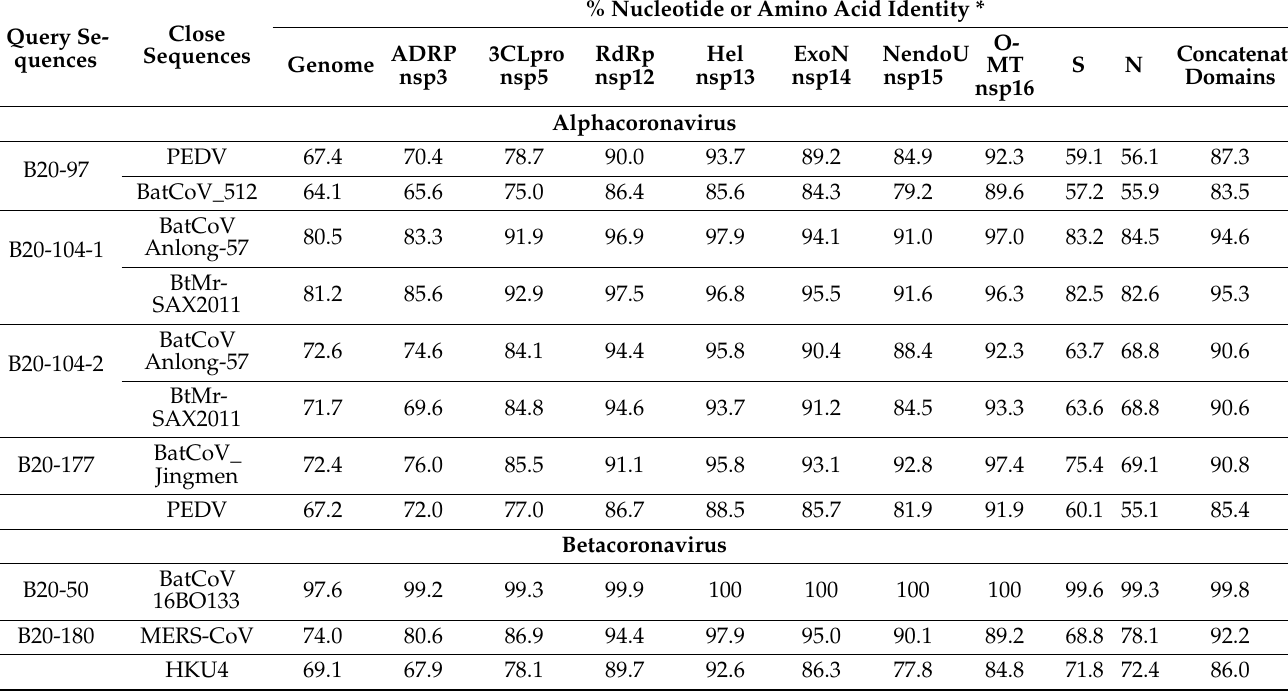
Table 3. Comparison of newly-identified bat coronaviruses with related viruses in conserved replicase domains, structural proteins, and genomes